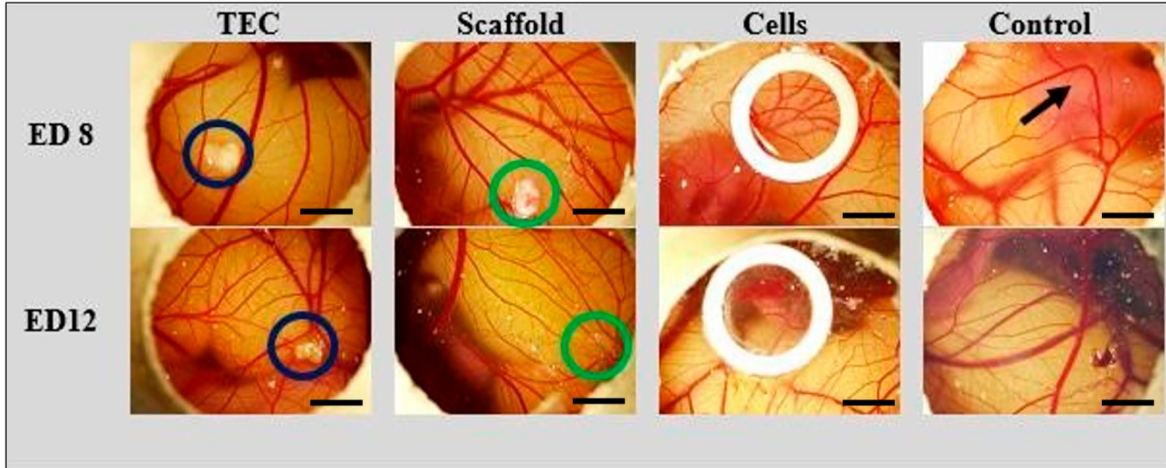
Figure A14. Architecture of CAM blood vessels in studied groups. Low-magnification (0.63 × ) view of the control and grafted CAMs on ED8 and ED12 obtained using bright-field microscopy. Angiogenic effects induced by the following chick embryo CAM grafts: 3D TEC (TEC; labeled with blue circles), liver AOSSs (scaffolds; labelled with green circles), and suspension of MDA-MB-231 cells (cells; xenograft suspension was placed into the chamber formed by a white rubber ring appeared on the photos as white circles), in comparison to natural embryonic development of CAM vasculature (control) during a period between ED8 (the area matching the grafting zone in the experimental groups is shown by the arrow) and ED12. Note that the degree of vascularization of CAM on ED8 was naturally variable between embryos. Representative images of the same eggs on ED8 and ED12 were used for analysis and shown for each group. Equal volume samples of the grafted TECs and AOSSs were used. The number of cells (2 × 10 5 ) in the cellular xenograft and TECs were approximately equal. An arrow in the control CAM, ED8, indicates the chick embryo residing underneath the CAM. The white dust on the surface of CAM is small fragments of the eggshell dropped on the CAM during the shell windowing. Note blood vessels converging toward the grafts in the TEC and scaffolds groups. Scale bars, 5